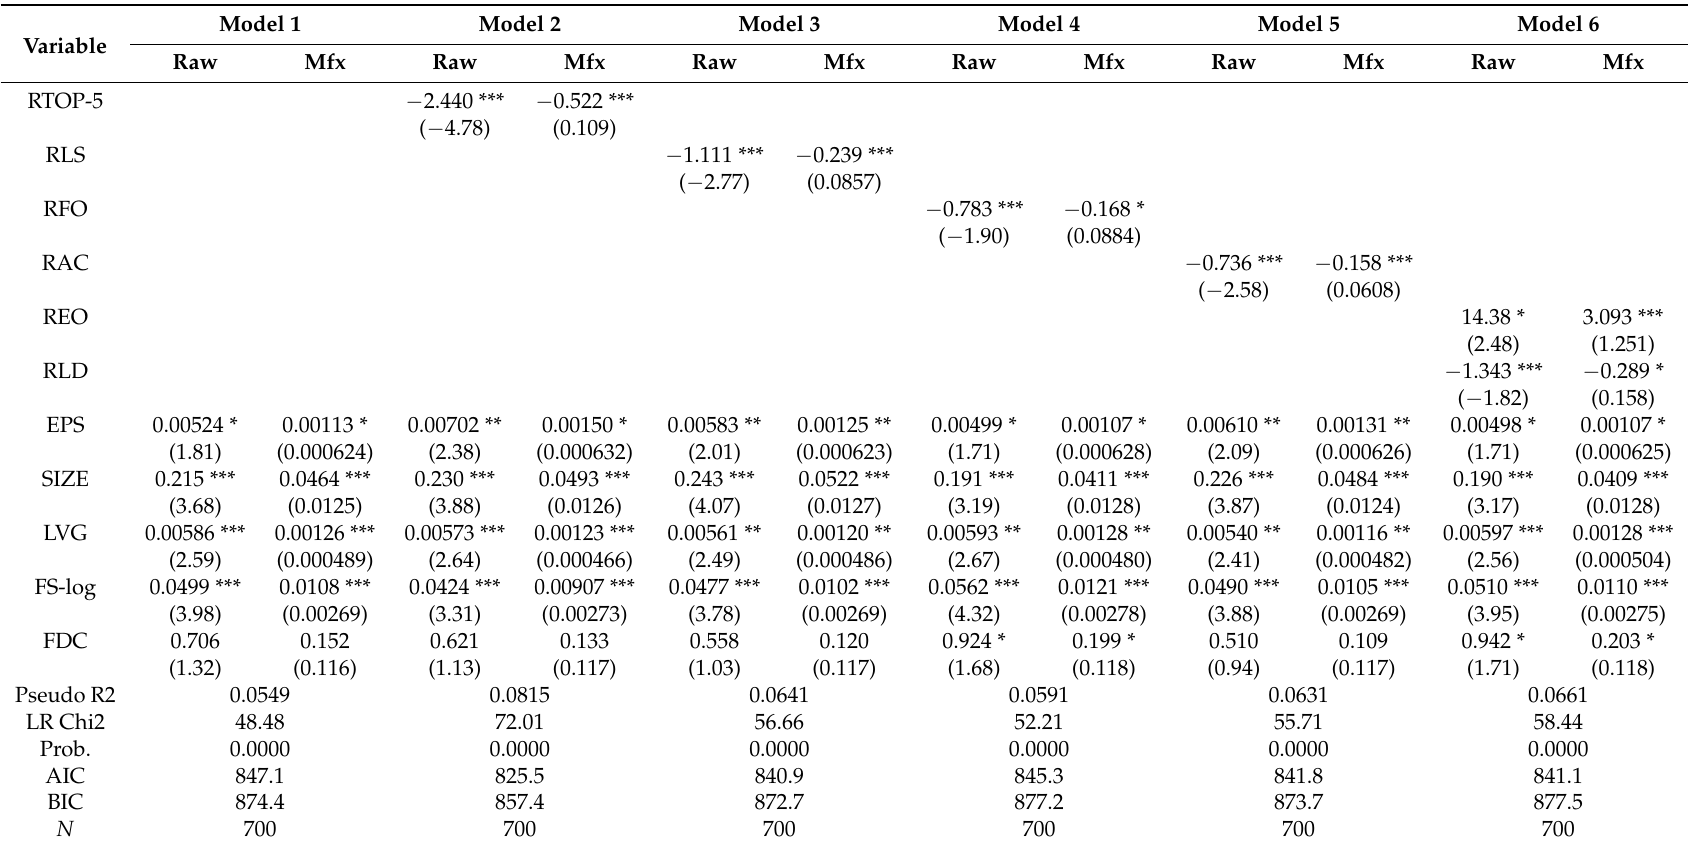
Table 4. Logistic Regression